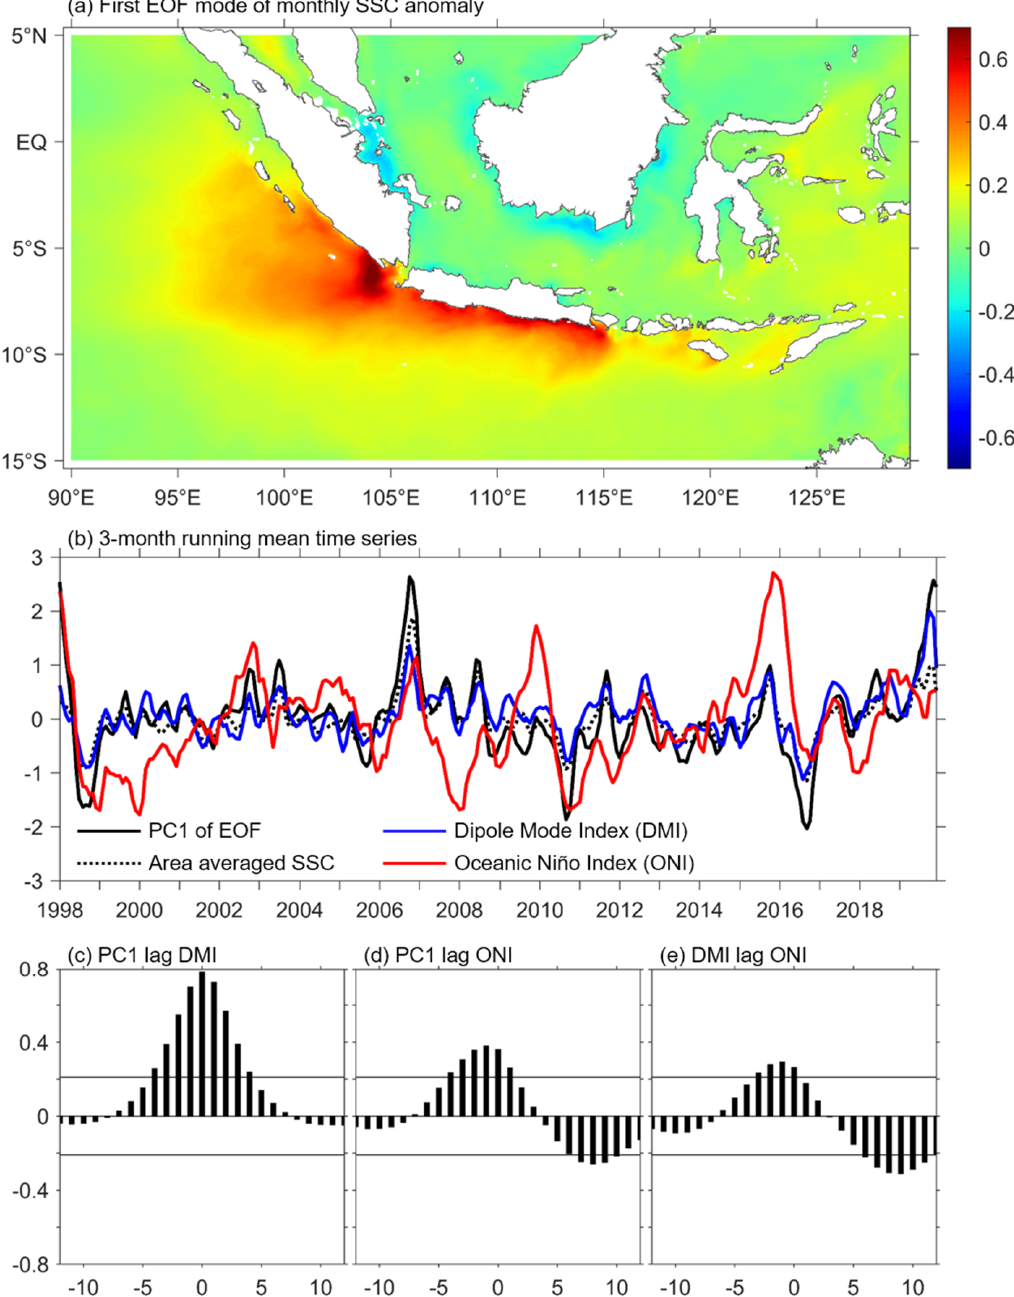
Figure 10. ( a ) The first EOF mode of the monthly SSC anomalies; ( b ) Three-month running time coefficient of the first EOF mode (PC1), area averaged SSC anomalies along the south coast of Sumatra-Java Islands, and DMI and ONI indices; and lag correlations between ( c ) PC1 and DMI; ( d ) PC1 and ONI; and ( e ) DMI and ONI. The positive/negative days on the x-axis in ( c – e ) indicate PC1 lagging/leading DMI, PC1 lagging/leading ONI, and DMI lagging/leading ONI, respectively. We define the positive and negative IOD events as those above 0.5 °C and below − 0.5